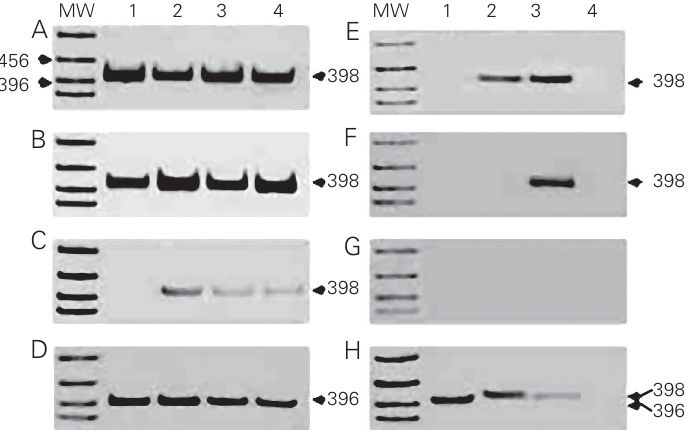
Figure 2. Analysis of CYP2A3 mRNA (398-bp product) expression in different tissues of untreated (lane 1), 3-methylcholanthrene- (lane 2), pyrazole- (lane 3), or ß-ionone-treated (lane 4) rats by RT-PCR. A , Nasal epithelium; B , lung; C , esophagus; D , liver; E , kidney; F , proximal intestine; G , middle intestine; H , distal intestine. MW, molecular weight standard (pBluescript SK+ digested with Hin fI; Stratagene, La Jolla, CA, USA) . The 396-bp product corresponds to